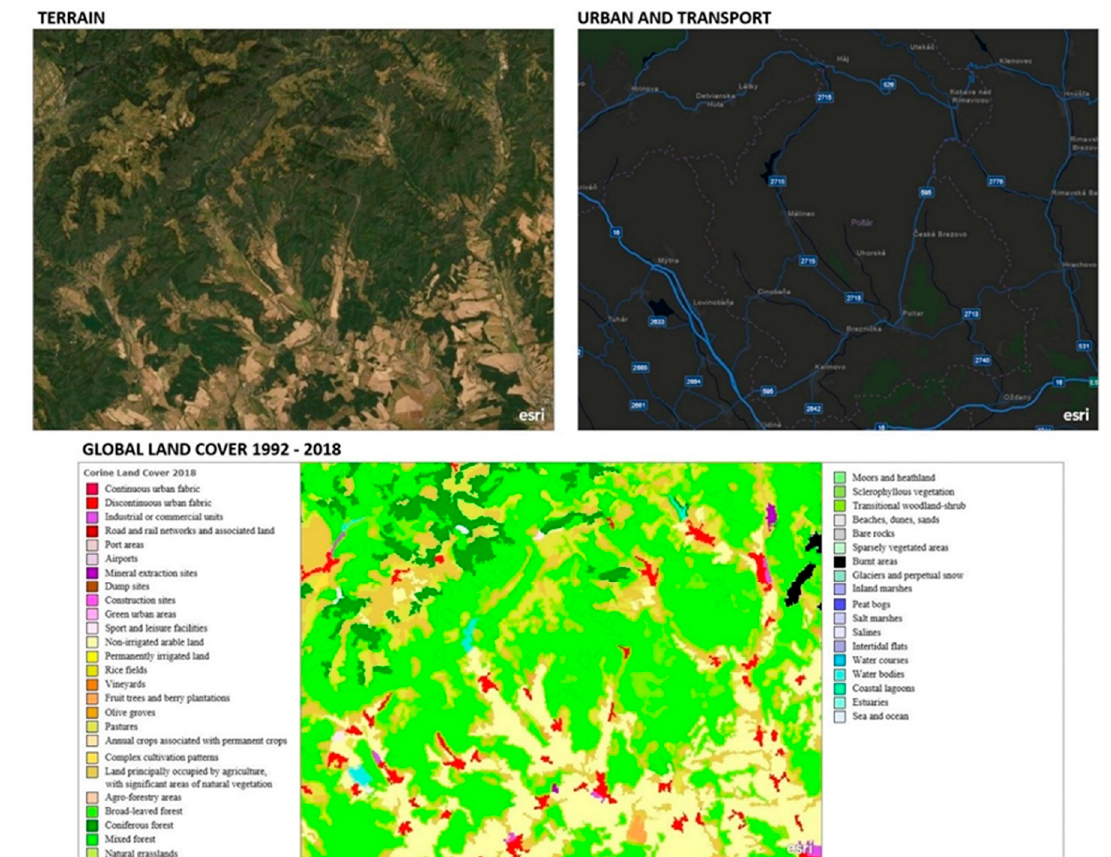
Figure 2. Map of the landscape cover of the studied area. [26].